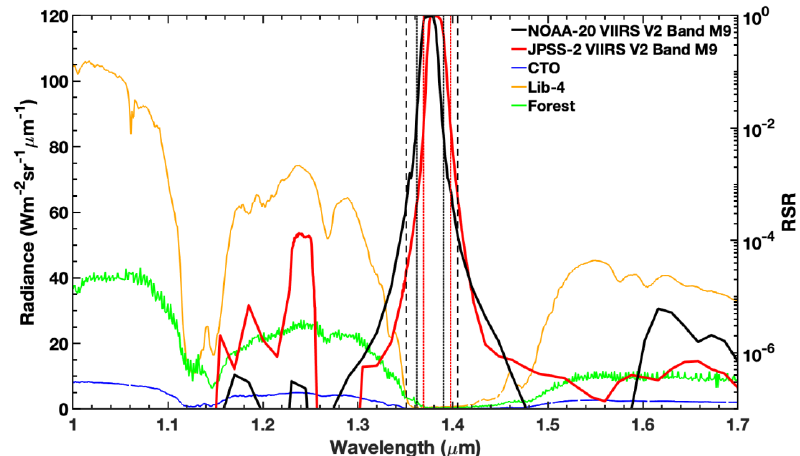
Figure 6. Same as Figure 4, except with NOAA-20 VIIRS V2 and JPSS-2 VIIRS V2 band M9 examples and the right y-axis limit extended to 10 − 7 . Here, the red vertical dotted lines indicate the measured lower and upper 1% response limits for JPSS-2 VIIRS. Both instruments have the same specified lower and upper 1% response limits (black vertical dashed lines). Remote Sens. 2020 , 12 , x FOR PEER REVIEW